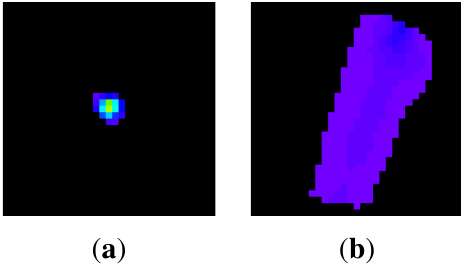
Figure 7. Results of the center displacement filter. ( a ) nodule; ( b ) blood